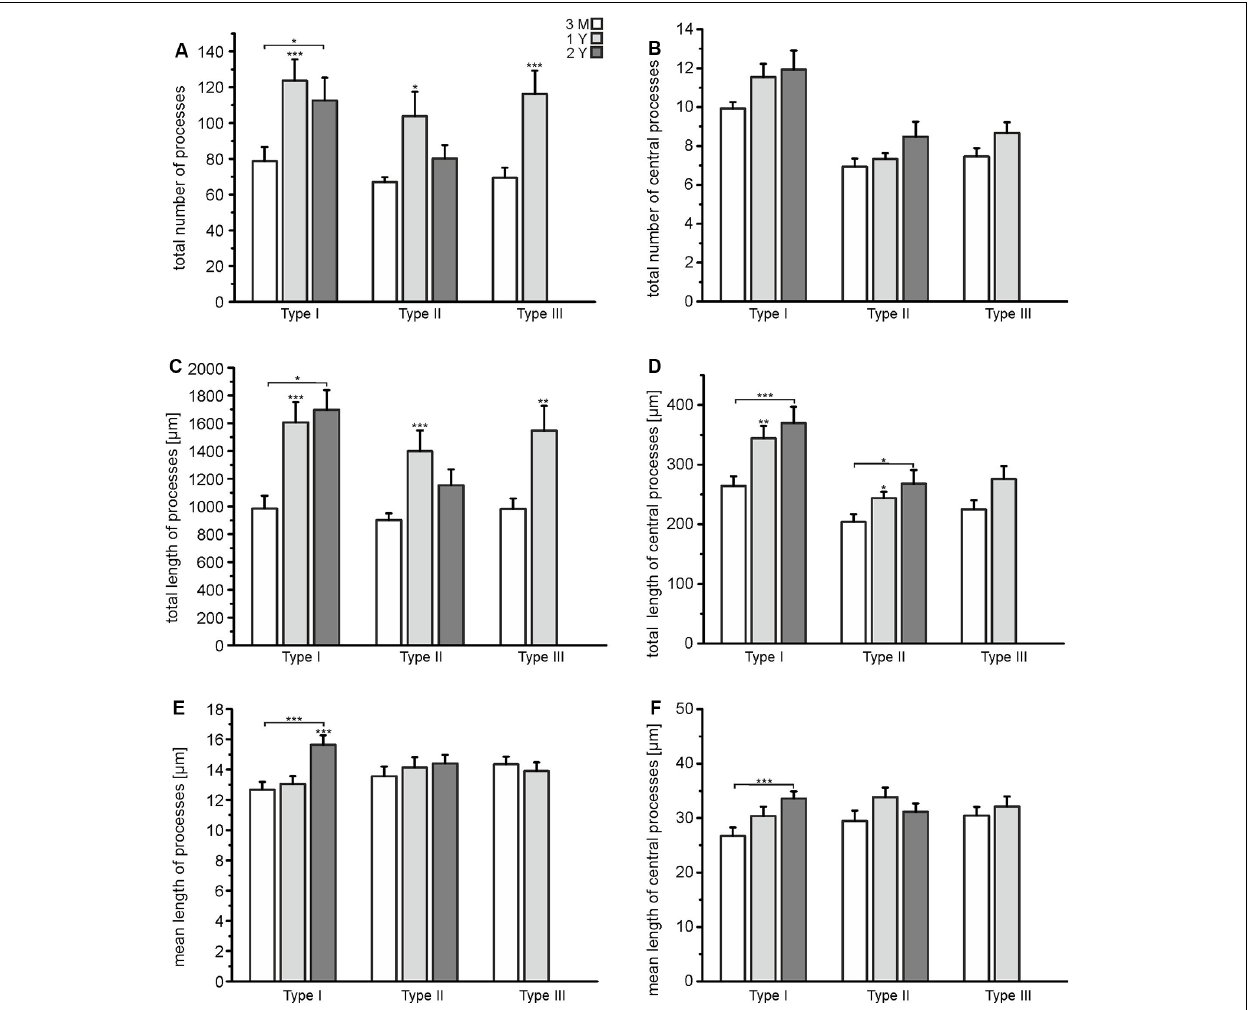
FIGURE 4 | Quantification of astrocyte complexity. (A) The total number of processes of each type of astrocyte for each age group. (B) The total number of central processes of each type of astrocyte for each age group. (C) The total length of all astrocytes of each type of astrocyte for each age group. (D) The total length of all central processes of each type of astrocyte for each age group. (E) Mean length of all processes for each type of astrocyte and each age group. (F) Mean length of central processes for each type of astrocyte and each age group. * p < 0.05; ** p < 0.01; *** p <